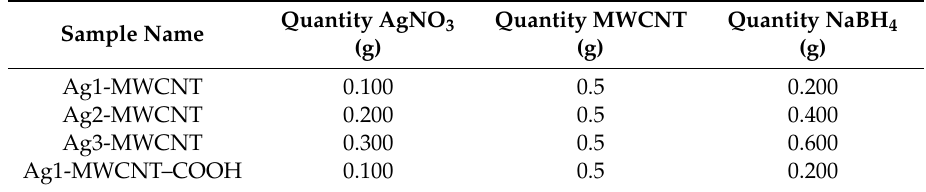
Table 1. Quantities of reagents and nomination of the Ag-decorated multiwall carbon nanotubes (MWCNT)